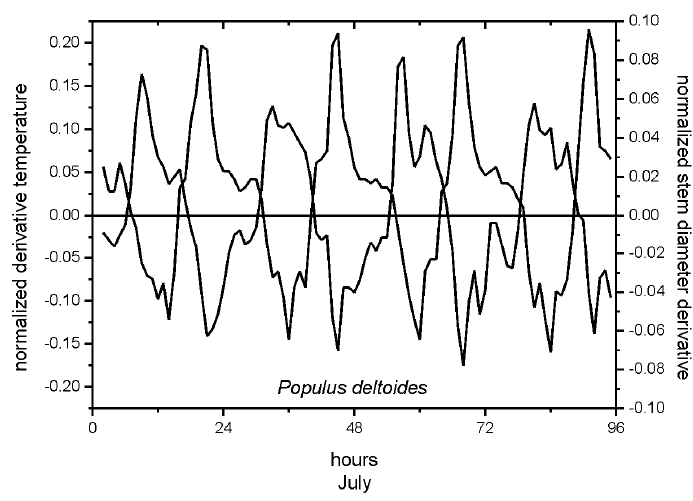
Figure 7. Normalized derivative of air temperature (black line) and stem diameter (grey line) of O. europaea , P. abies , P. deltoides trees in mid ‐ summer.